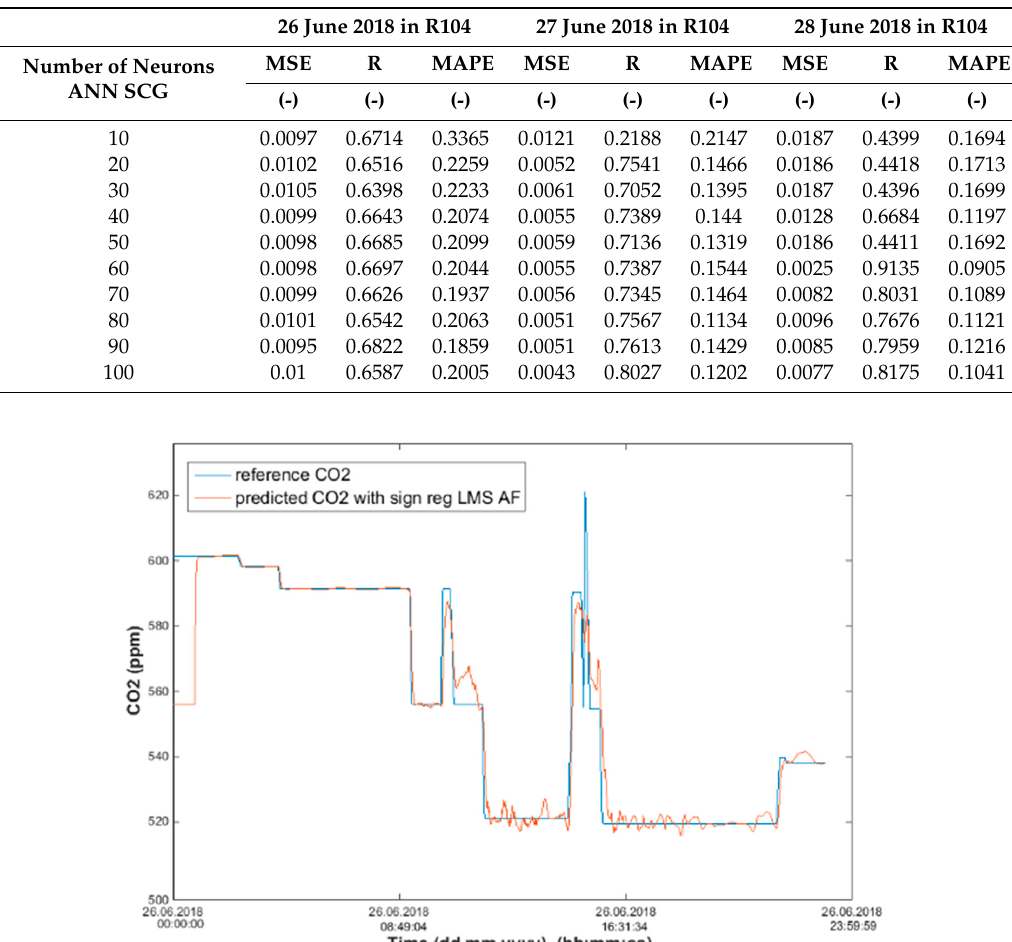
Table 4. Learned ANN SCG from 25 June 2018 in R203 (with T in and rH in ) and prediction with cross-validation for 26 June 2018 in R104 (with T in and rH in ), 27 June 2018 in R104 (with T in and rH in ), and 28 June 2018 in R104 (with T in and rH in ).